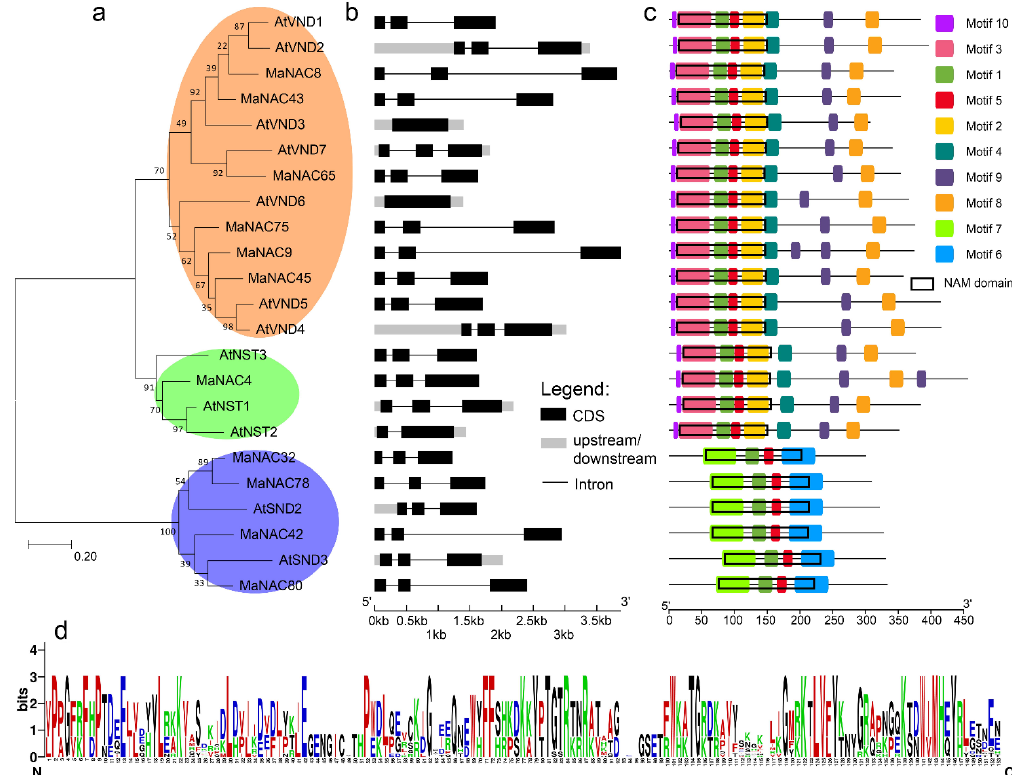
Figure 6. Phylogeny, gene structure and motif analysis of lignin biosynthesis-related NAC genes from M. albus and Arabidopsis . ( a ) Phylogenetic tree of 11 MaNAC proteins and 12 AtNAC proteins. The phylogenetic tree was constructed via MEGA 7.0, with the maximum likelihood method. The bootstrap test was performed with 1000 replicates. Three subgroups are shown in different colors. ( b ) Intron/exon structures of M. albus and Arabidopsis NAC genes. ( c ) M. albus and Arabidopsis NAC protein motifs and the position of the no apical meristem (NAM) domain. ( d ) Sequence logo of the NAM domain in M. albus . The bit score represents the information content for each position.